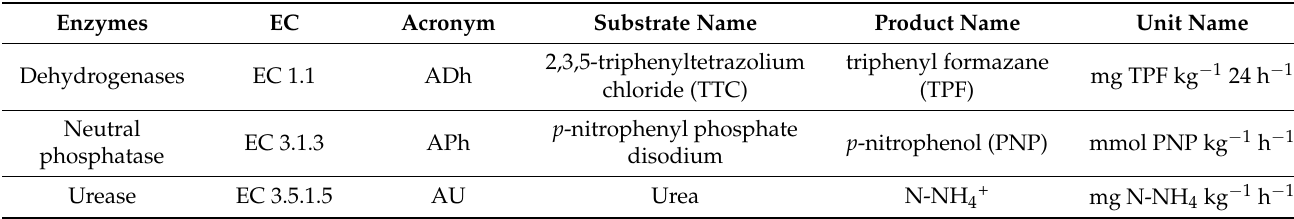
Table 2. Determination of the activity of soil enzymes.